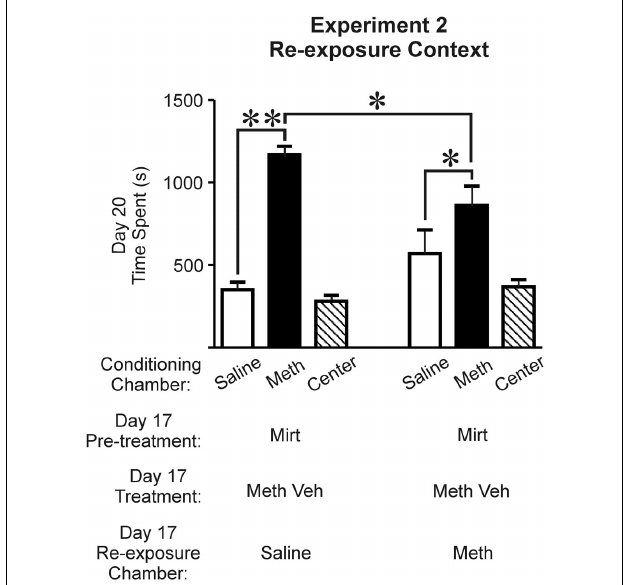
FIGURE 3 | Mirtazapine administered prior to re-exposure to the Meth-paired chamber, but not the saline-paired chamber, on day 17 inhibited the expression of Meth-induced CPP on day 20. Rats re-exposed to the saline-paired chamber ( n = 11; left set of bar graphs) or to the Meth-paired chamber ( n = 6; right set of bar graphs) both expressed a preference for the Meth-paired chamber ( post hoc Newman–Keuls; * p < 0.05, ** p < 0.01). However, the magnitude of the preference for the Meth-paired chamber was significantly less in rats re-exposed to the Meth-paired chamber ( post hoc Newman–Keuls, p < 0.05).Time spent in the center chamber is presented for qualitative comparisons, and was not included for statistical analysis. Saline, saline-paired chamber; Meth, methamphetamine-paired chamber; Center, central neutral chamber; Mirt, mirtazapine (5mg/kg); MethVeh, methamphetamine vehicle (0.9%